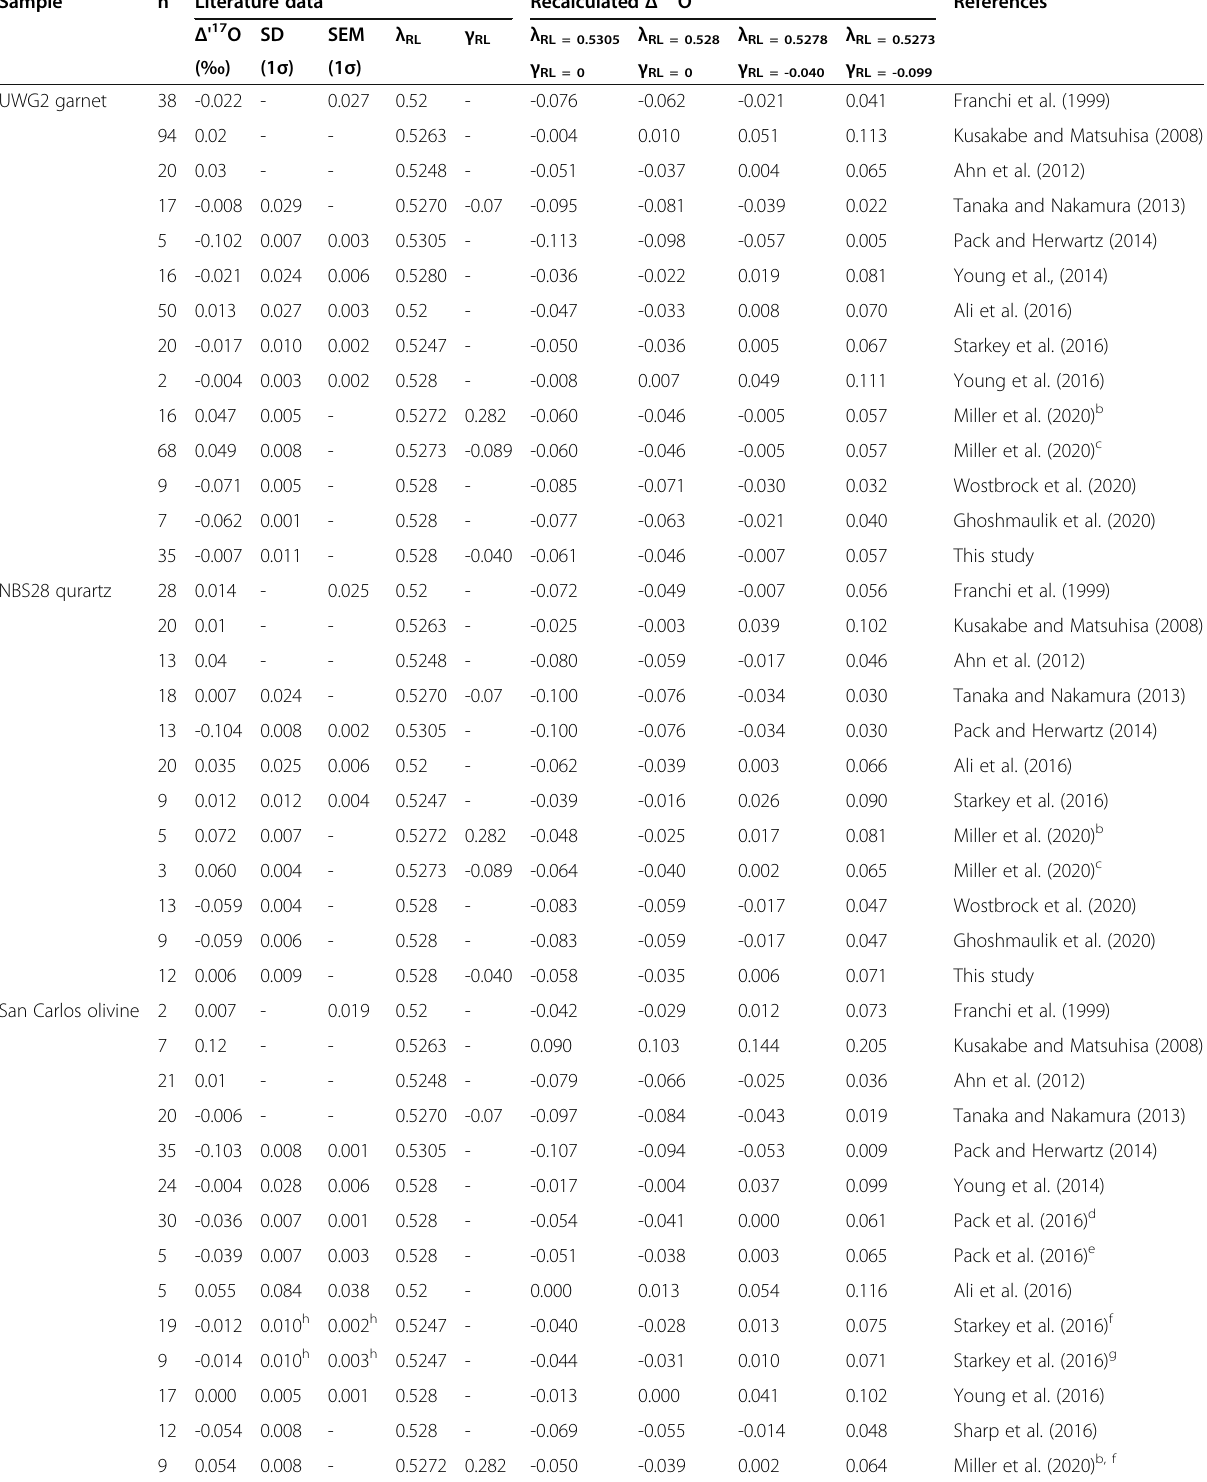
Table 4 Literature data of Δ ' 17 O and recalucalted Δ ' 17 O relative to different assigned reference lines